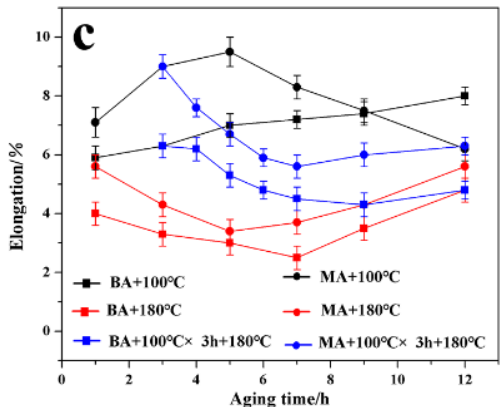
Figure 7. Evolution of mechanical properties of Al–9Si–1.2Cu–0.4Mg–0.6Zn modified alloy and Al–9Si–1.2Cu–0.4Mg-based alloy under three types of artificial ageing processes: ( a ) UTS, ( b )YS, ( c )E% (BA—Base alloy, MA—0.6 wt% Zn modified alloy).